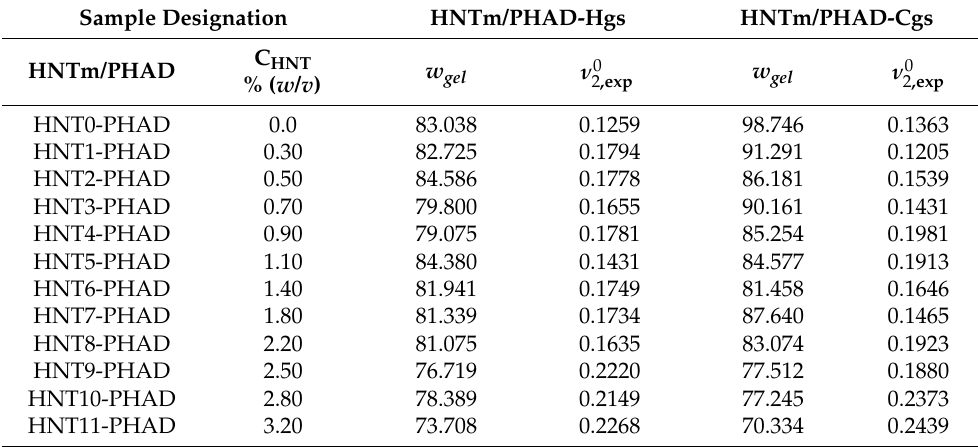
Table 1. The sample codes and feed compositions of ternary hybrid HNTm/PHAD